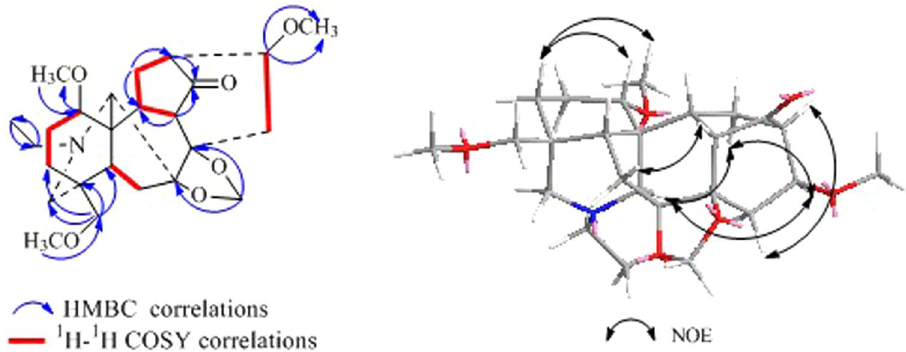
Figure 7. Key 1 H– 1 HCOSY, HMBC and NOSEY correlations of 4